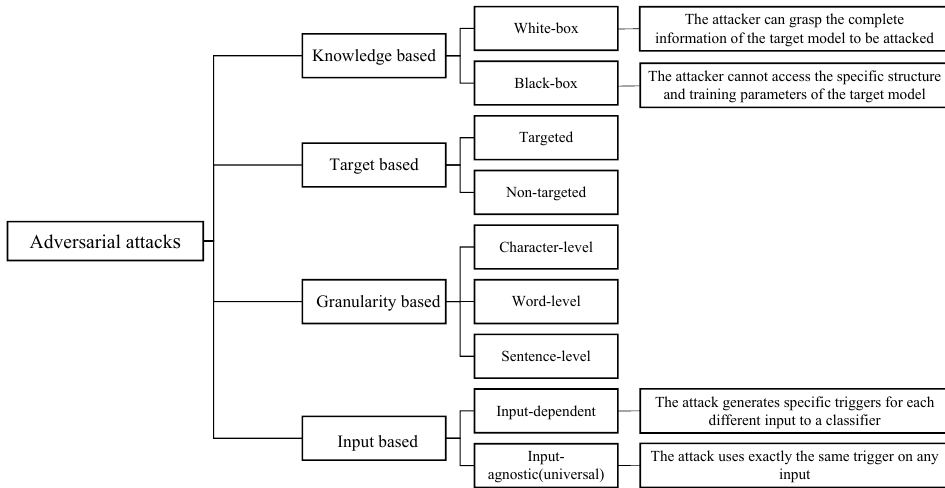
Figure 2. Categories of adversarial attack methods on textual deep learning